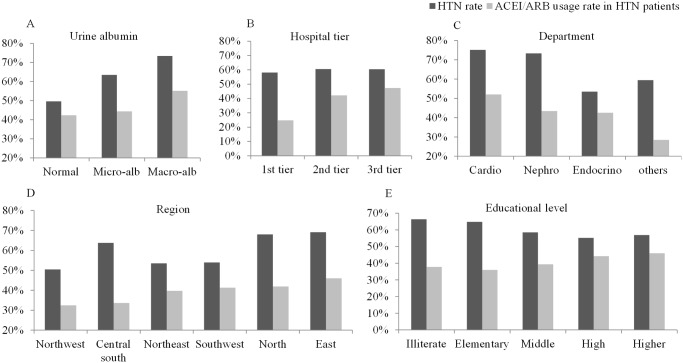
Hypertension rate of the study population and ACEI/ARB usage rate in the hypertensive patients.Patients with higher ACR and lower educational level had higher rate of hypertension (p < 0.001 for both); Compared with cardiology and nephrology departments, patients visited in endocrinology department had lower rate of hypertension (p < 0.001); There were not significant differences in region and visiting hospital titer (p > 0.05 for both). In hypertension population, ACEI/ARB usage rate was higher in patients with higher ACR (p < 0.0001), higher educational level (p < 0.0001) and higher tier of visiting hospital (p < 0.0001); Cardiologists had the highest usage rate, while internal medicine/others had the lowest (p < 0.0001); East China had the highest usage rate, with the North, Southwest and Northeast regions following, while Central, South and Northwest China had relatively lower rates (p < 0.0001).